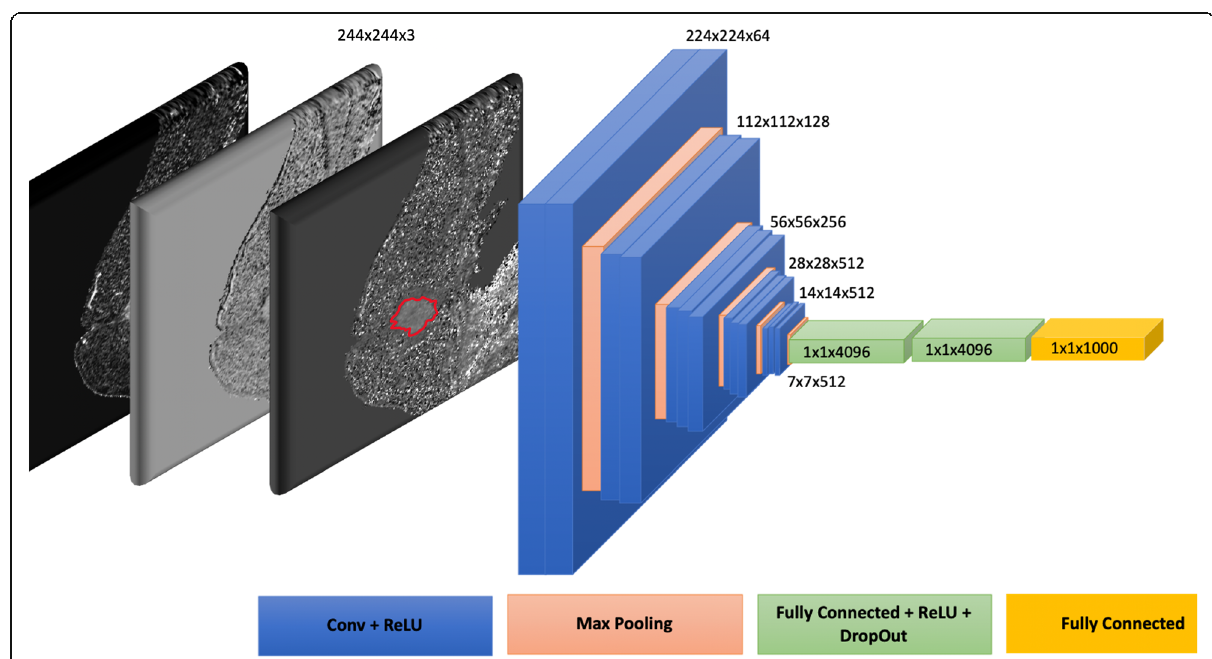
Fig. 4 Schematic representation of adapted VGG-16 network for DLB feature extraction. Each layer is defined by corresponding color legend at the bottom of the figure. Input was a 3D volume for a single slice of the three kinetic maps. Features were extracted from the last fully connected layer (yellow), resulting in a feature vector of 1000 features for each 2D slice. Conv: Convolutional layer; ReLu: Rectified linear